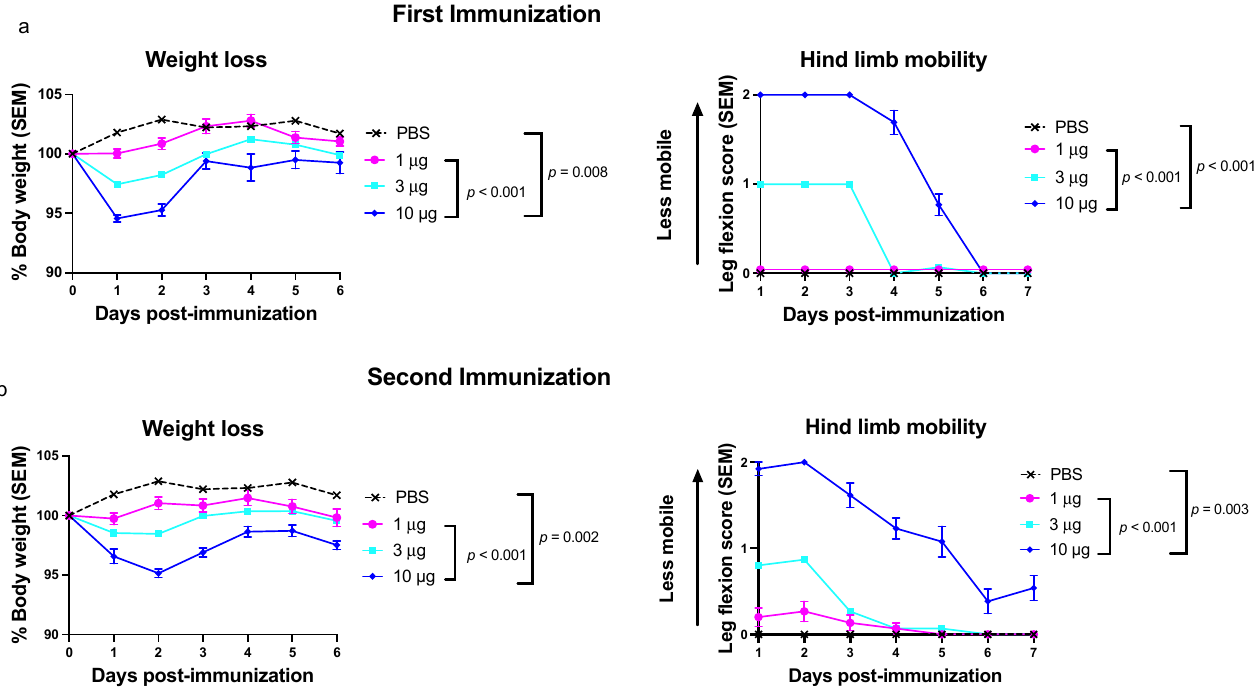
Figure 1. Trivalent mRNA-lipid nanoparticle (LNP) vaccine toxicity is dose dependent. Weight loss and hind limb mobility were assessed after ( a ) the first and ( b ) second immunization. The trivalent mRNA-LNP and phosphate-buffered saline (PBS) vaccination groups were weighed on days 1–6 post-infection and evaluated for mobility in the inoculated hind limb on days 1–7 post-immunization (weight: n = 15 animals in the 1- µ g and 3- µ g groups, 9 animals in the 10- µ g group, and 5 animals in the PBS group; hind limb mobility: n = 15 mice in the 1- µ g and 3- µ g group, 13 mice in the 10- µ g group, and 5 mice in the PBS group). P values were not calculated comparing 3 µ g with PBS, 1 µ g, or 10 µ g. p values were determined by comparing area under the curve (AUC) using the Mann–Whitney–Wilcoxon test with Holm adjustment for multiple